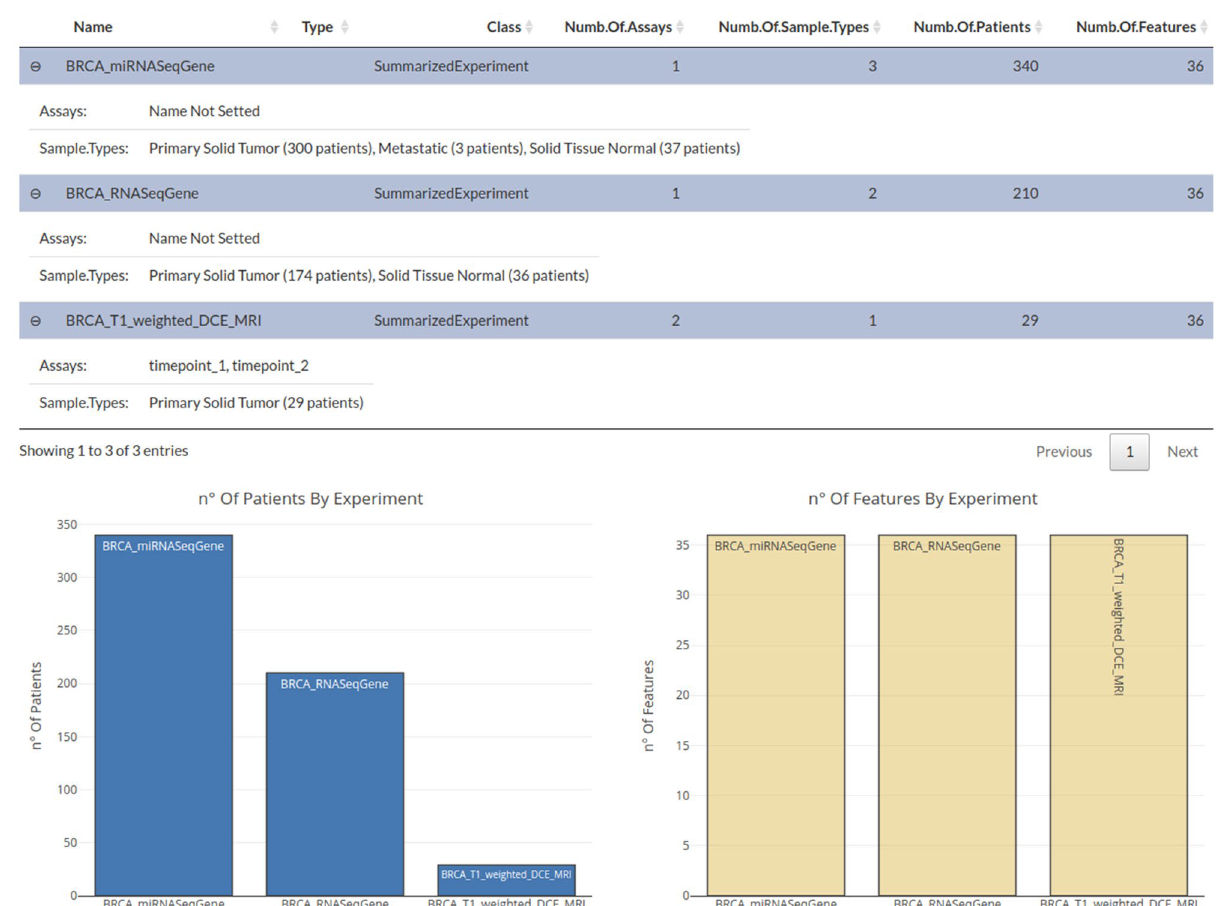
Figure 2. Data import summary. This Data Import tab shows the experiment data of the described radiogenomic case study. In the top table, the names of all MAE experiments are listed and for each of them, the assays (timepoint_1 and timepoint_2 in the case of BRCA_T1_weighted_DCE_MRI) and the sample types are reported. For each sample type, the number of patients is specified. The number of features and patients for each experiment are also represented as histogram (for a simple graphic representation, the number of features was limited to 36 for all experiments). The figure is generated by using R software version 3.6.1 (https ://www.r-proje